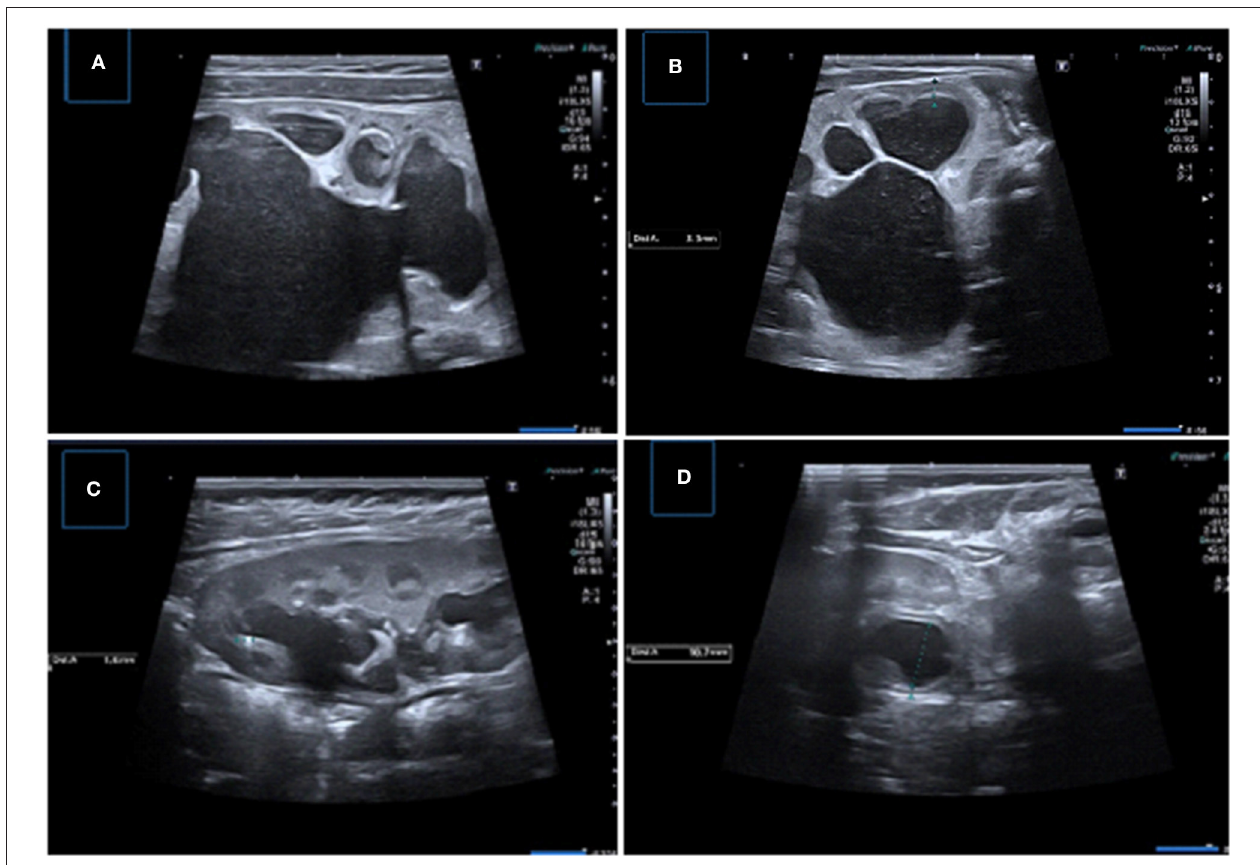
FIGURE 7 | Samples of important US findings in giving surgical desicion. (A,B) Longitudinal and transverse US images of the left kidney demonstrating severe pelvicaliyceal dilatation with serious parenchymal thinning, medullary compression, and echogeneity and luminal debris suggesting infection and/or cristalury. (C) Longitudinal US image showing pelvicalyceal dilatation with the presence of micro calculi, (D) Transverse US image showing uroepithelial thickening and layering of low-level debris consistent with